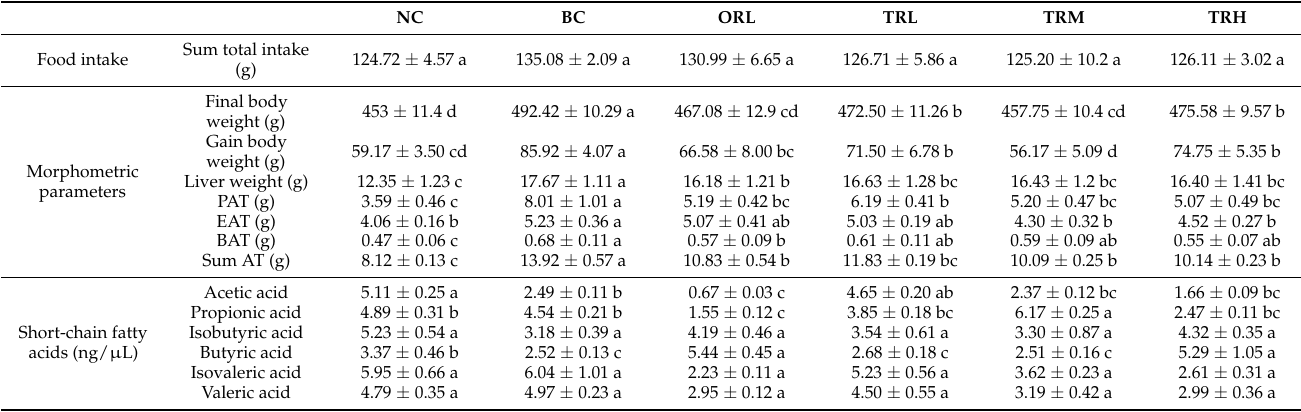
Values are represented as mean ± standard deviations. Values in a row with the same letter are not significantly different ( p > 0.05). Difference between groups was assessed by Dunnett post hoc test after a significant one-way ANOVA ( p < 0.05). NC: Normal control group, chow diet; BC: Blank control group, high-fat diet; ORL: Positive control group, orlistat; TRL: Low-dose group, trilobatin; TRM: Middle-dose group, trilobatin; TRH: High-dose group, trilobatin; PAT: Perirenal adipose tissue; EAT: Epididymal adipose tissue; BAT: Brown adipose tissue; AT: Adipose